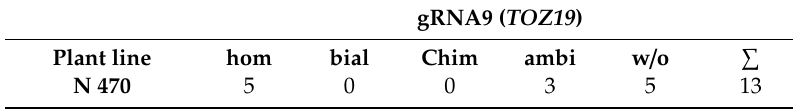
Table 5. Numbers of modifications in TOZ19 . Abbreviations: hom—homozygous editing, bial—biallelic editing, Chim—Chimera, ambi—edited but ambiguous, w / o—without editing / unmodified, tested lines.